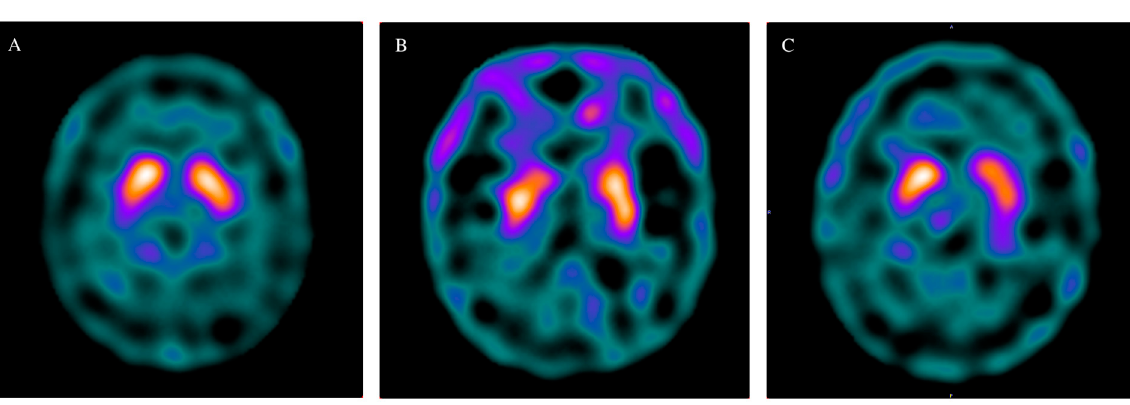
Table 3. TRODAT ratios of the three groups.